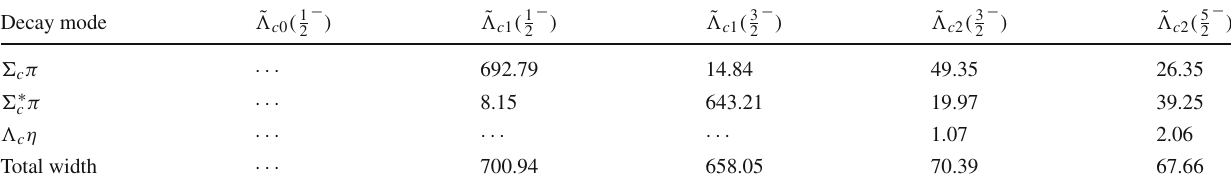
Table 5 Strong decays of the ˜ (cid:2) c ( 1 P ) states with the predicted masses in MeV Decay